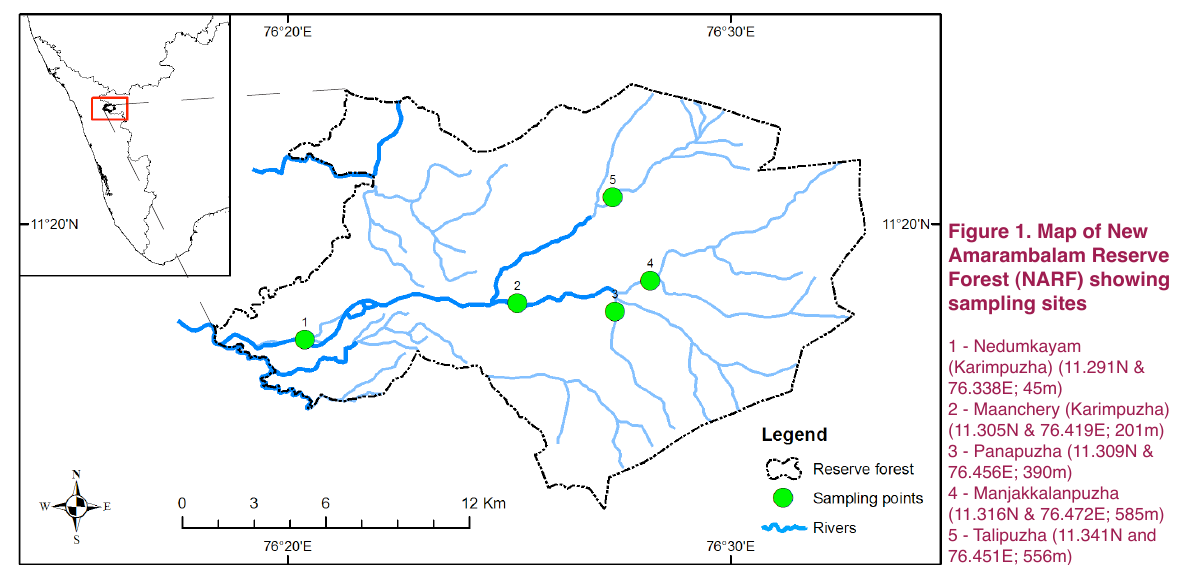
Figure 1. Map of New Amarambalam Reserve Forest (NARF) showing sampling